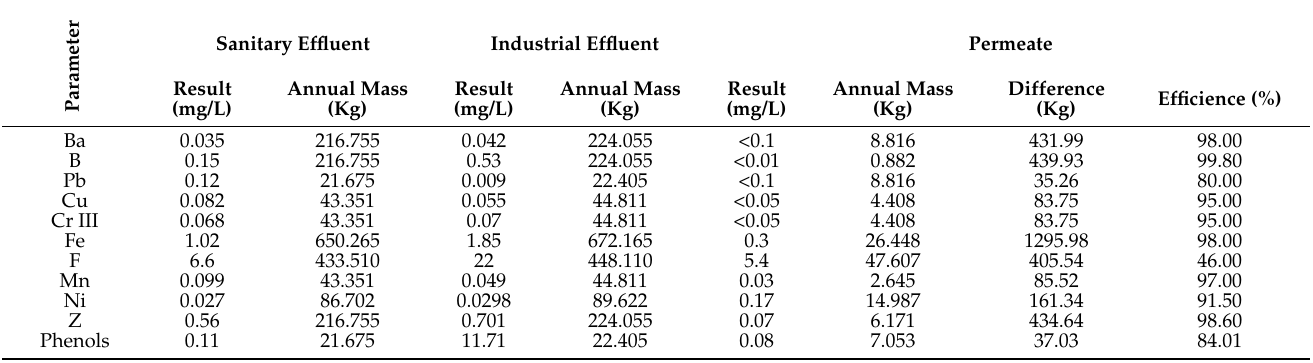
Table 4. Indices obtained by the permeate difference with the possible launching according to